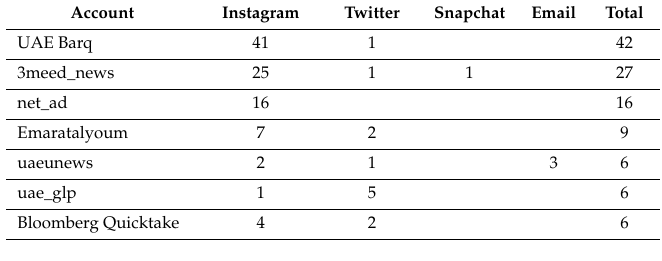
Table 2. Most frequently accessed social media accounts (by platform).